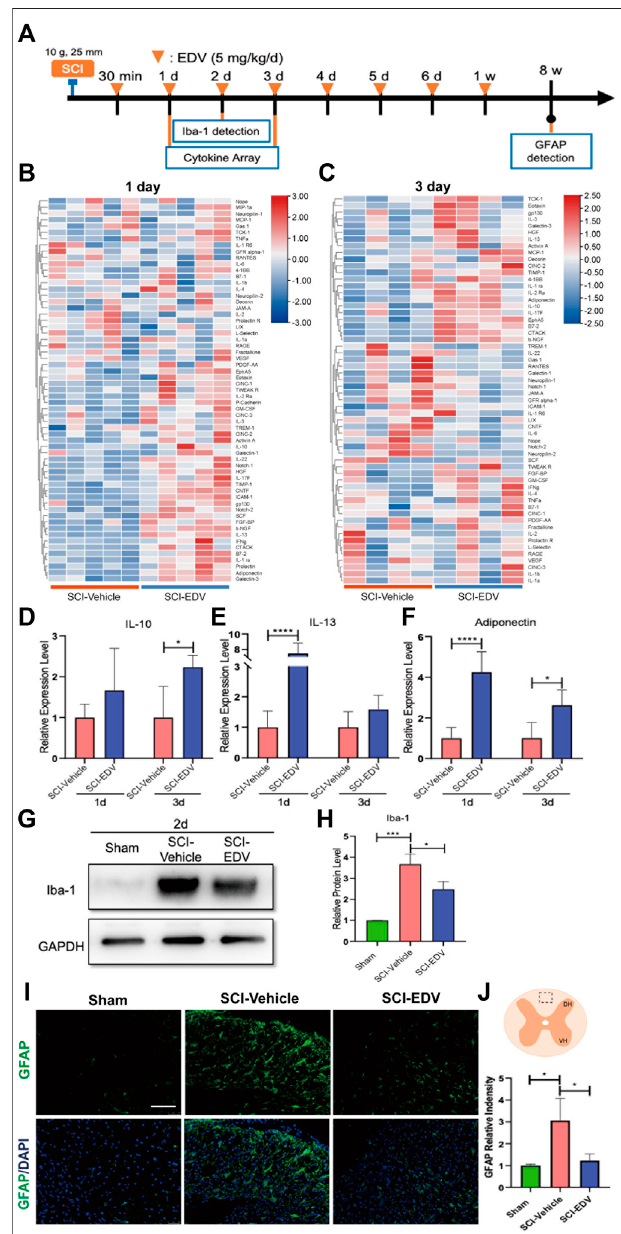
FIGURE 5 | Edaravone reduced in fl ammation in the acute phase post SCI. (A) Timeline of the experiment about edaravone ’ s effect on in fl ammation. (B,C) HeatmapshowingthechangingproteinsbetweenSCI-VehicleandSCI- EDV groups at 1d (B) and 3d (C) post SCI. (D – F) Quanti fi cations of the relative levels of IL-10 (D) , IL-13 (E) and adiponectin (F) . Data are expressed as mean ± standard deviation. (G,H) Western blot analysis of Iba-1 (G) and quanti fi cation (H) at 2d post SCI are shown. (I) Spinal cord injury epicenter GFAP immuno fl uorescence 8 weeks post SCI. Scale bar = 100 μ m. (J) Upper, the marked square in the spinal cord diagram indicates the fi eld of microscope chosen for the representative images. Lower, quanti fi cation of GFAP. Statistical signi fi cance was determined by two-way ANOVA with Sidak ’ s multiple comparisons test (D – F) or one-way ANOVA with Tukey ’ s posthoc test (H,J) .* p < 0.05,*** p < 0.001,and**** p < 0.0001, n =5(cytokine array at 1 d. p.i.), n = 4 (3 d. p.i.), bar = 100 μ m (I) .